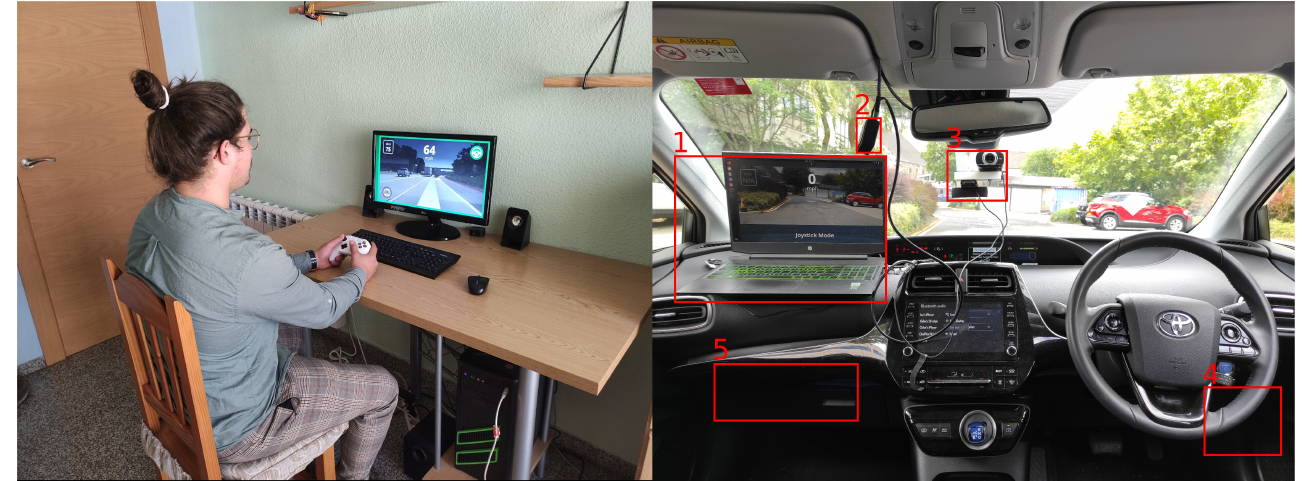
Figure 3. Remote station ( left ) and on-board station ( right ). On-board station’s components: (1) lap- top; (2) Panda (USB to CAN); (3) webcam; (4) OBD-II Port; and (5)